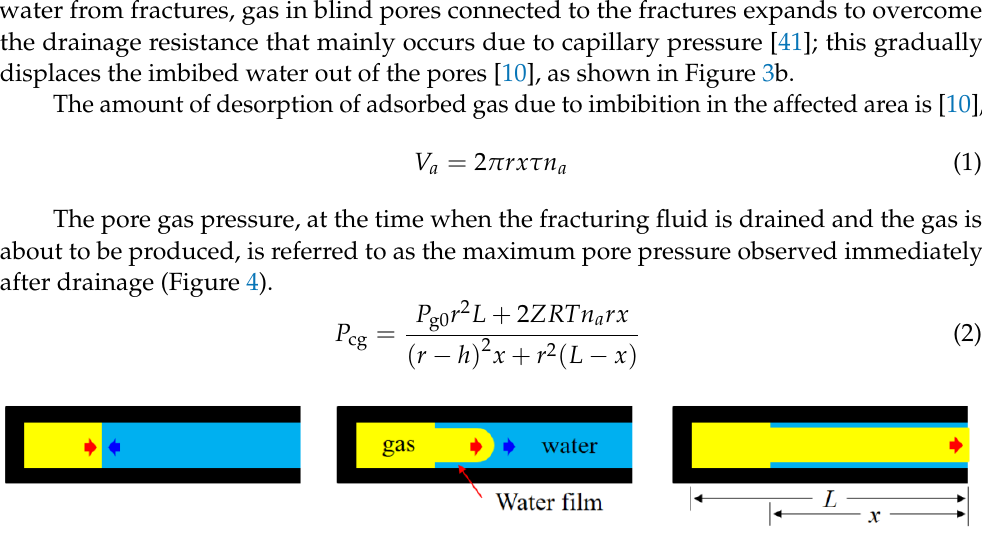
Figure 3. Change in the gas – water state in blind pores during the process of imbibition and drainage (according to Wang et al., [10]). ( a ) Change in the gas – water state in blind pores during the imbibi- tion process. ( b ) Change in the gas – water state in blind pores during the drainage process.